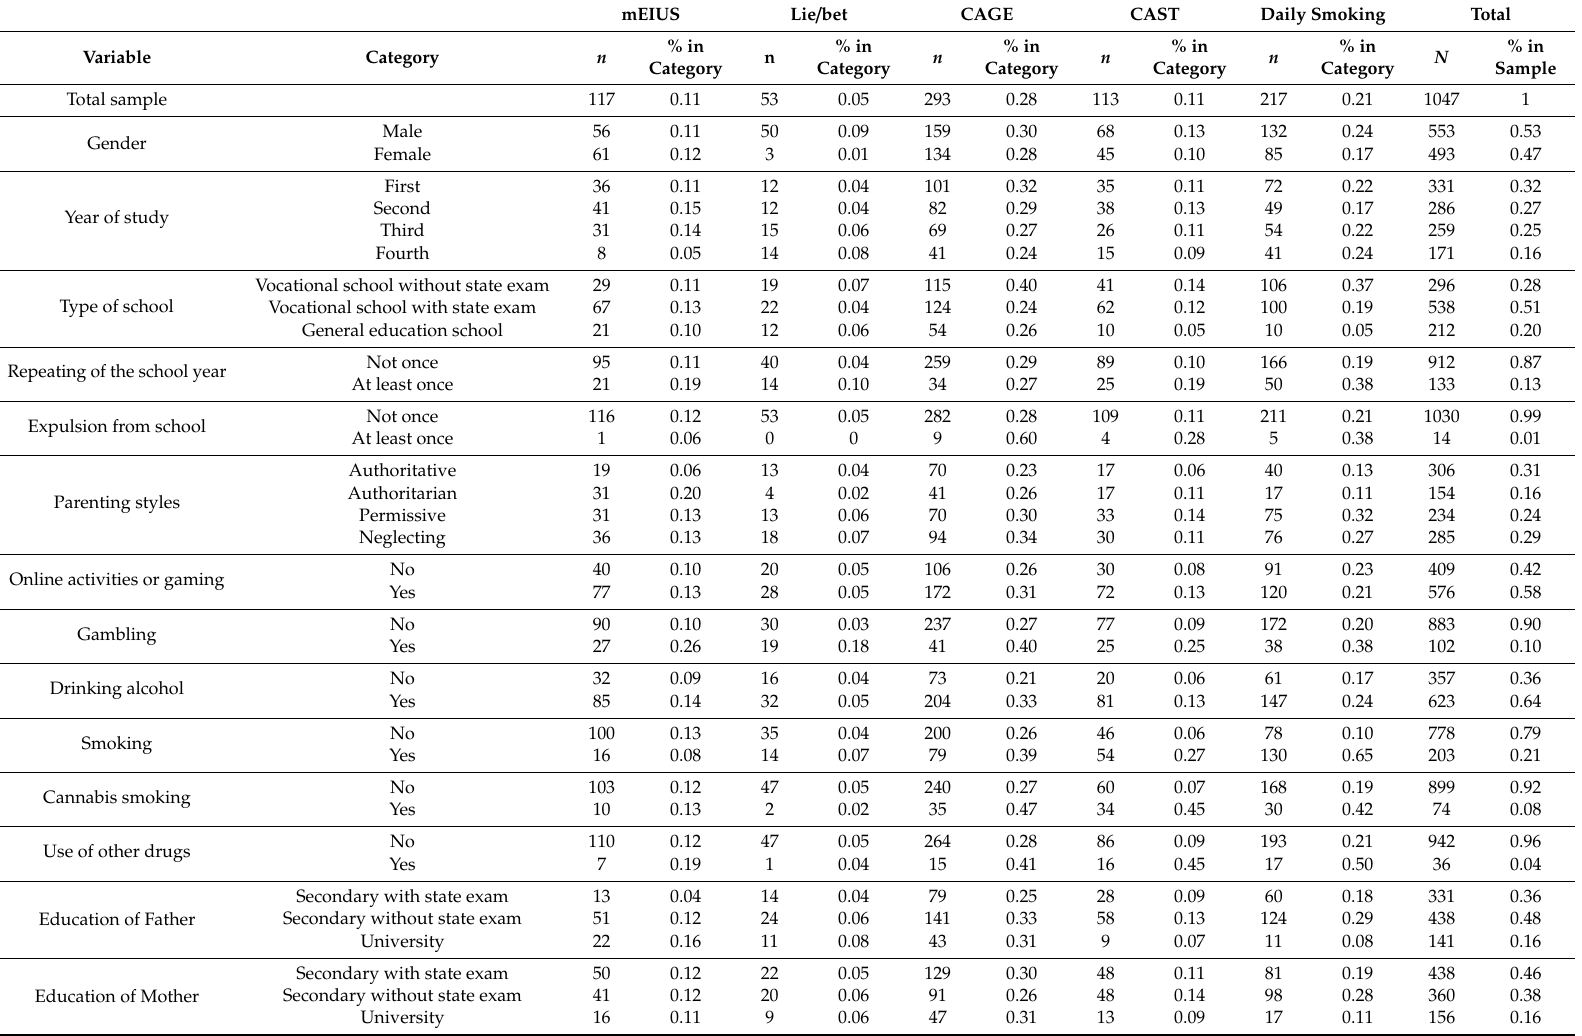
Table 1. Prevalence of risky behavior—mEIUS, Lie / bet, CAGE, CAST, and daily